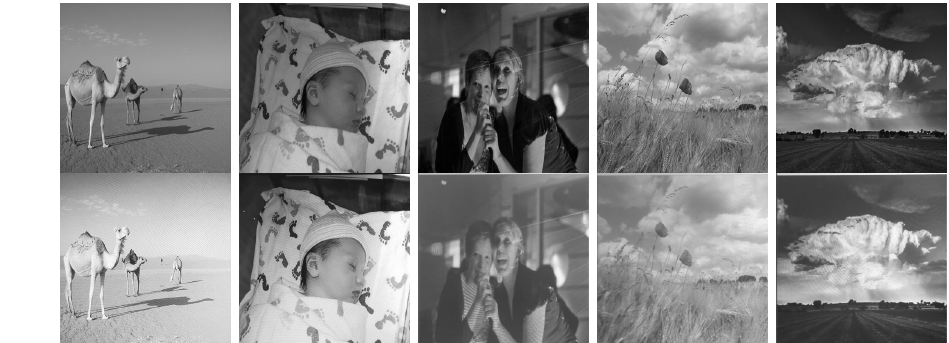
Figure 8. Moiré pattern test results from COCO 2014 gray dataset by the fine-tune network. ( a ) pure images; ( b ) images (512 × 512) with moiré pattern.